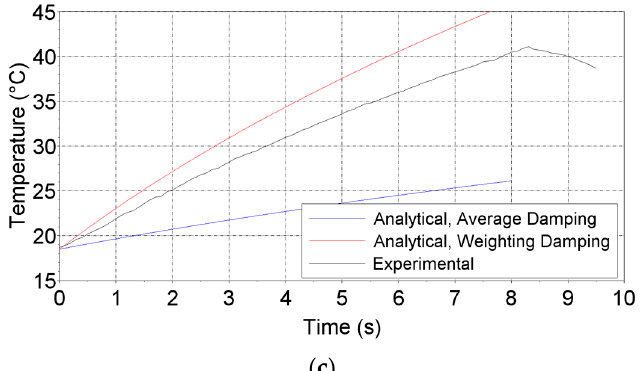
Figure 22. Experimental and computational model temperature comparison, Inconel 625, UHCF specimen: ( a ) Maximum stress = 270 MPa, t on = 0.2 s, t off = 0.2 s, 23 pulses; ( b ) Maximum stress = 270 MPa, t on = 0.2 s, t off = 0.2 s, forced convection, h = 1500 W/(m 2 .K), 58 pulses; ( c ) Maximum stress = 220 MPa, continuous excitation.